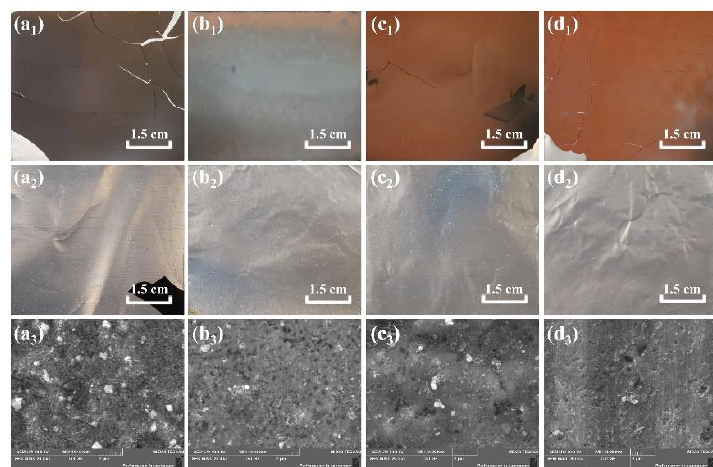
Figure 9. E ff ect of air flow on spent LFP cathode plates: ( a 1 – d 1 ) Images of cathode plates at an air flow Figure 9. Effect of air flow on spent LFP cathode plates: ( a 1 –f 1 ) Images of cathode plates at an air flow rate of 20–450 mL / min; ( a 2 – d 2 ) images of Al foils at an air flow rate of 20–450 mL / min; ( a 3 – d 3 ) SEM rate of 20–450 mL/min; ( a 2 –f 2 ) images of Al foils at an air flow rate of 20–450 mL/min; ( a 3 –f 3 ) SEM images of Al foils at an air flow rate of 20–450 mL / images of Al foils at an air flow rate of 20–450 mL/min.